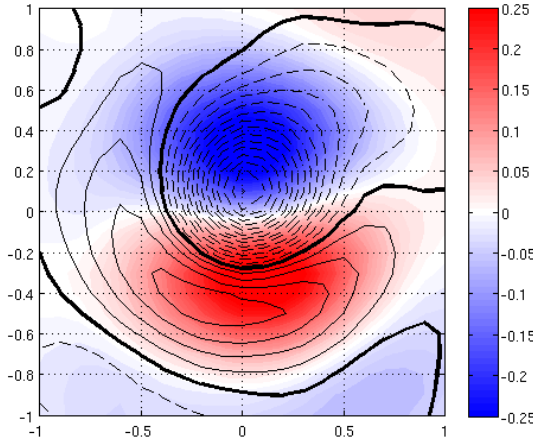
Figure 5. Map of